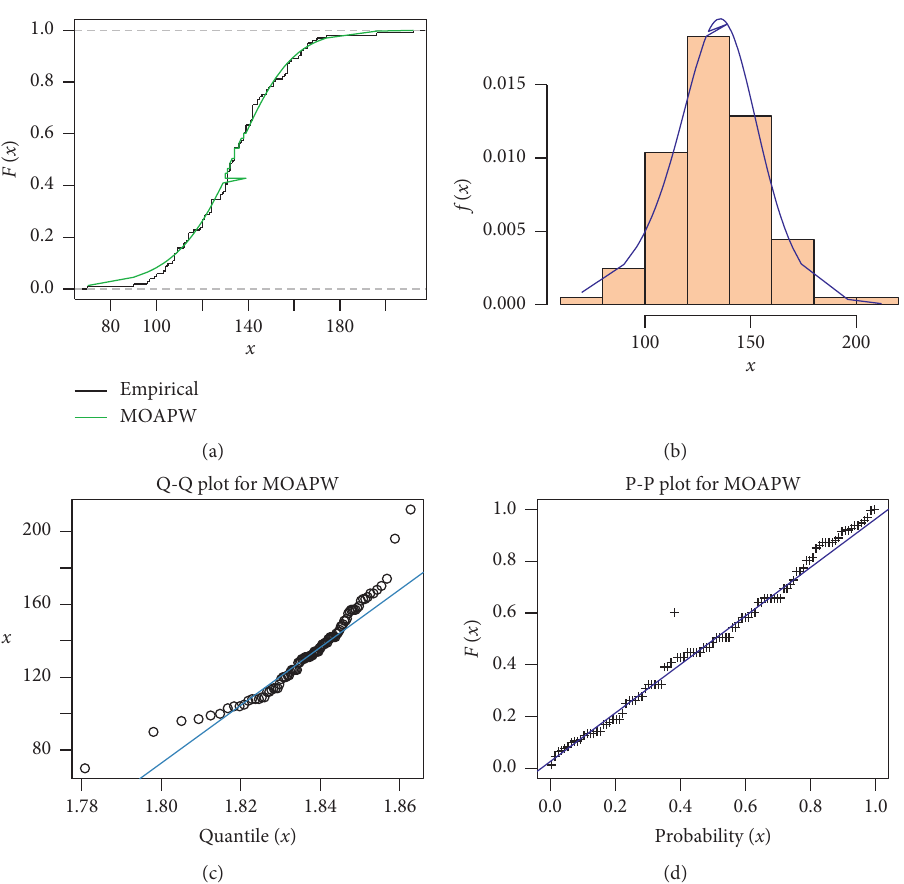
Figure 6: Cumulative function, empirical CDF, PDF, Q-Q, and P-P plots for the MOAPW distribution, for the first data